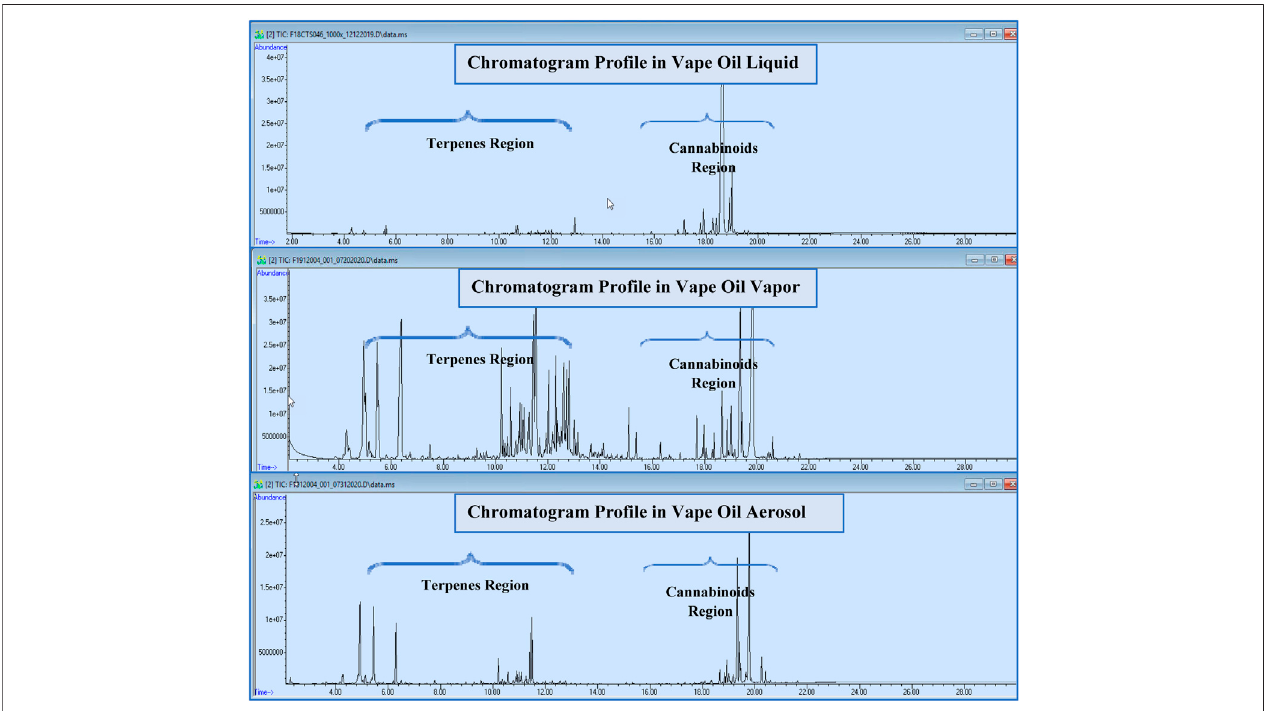
FIGURE 2 | Total ion chromatograms of liquid, vapor, and aerosol phases in one of tested samples.